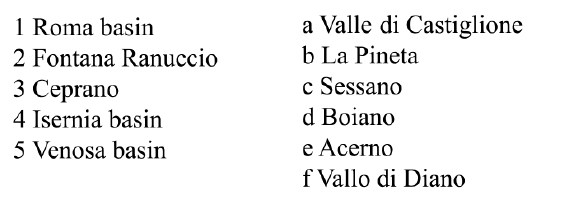
Fig. 1. Location of the compiled archaeological sites and palyno- logical